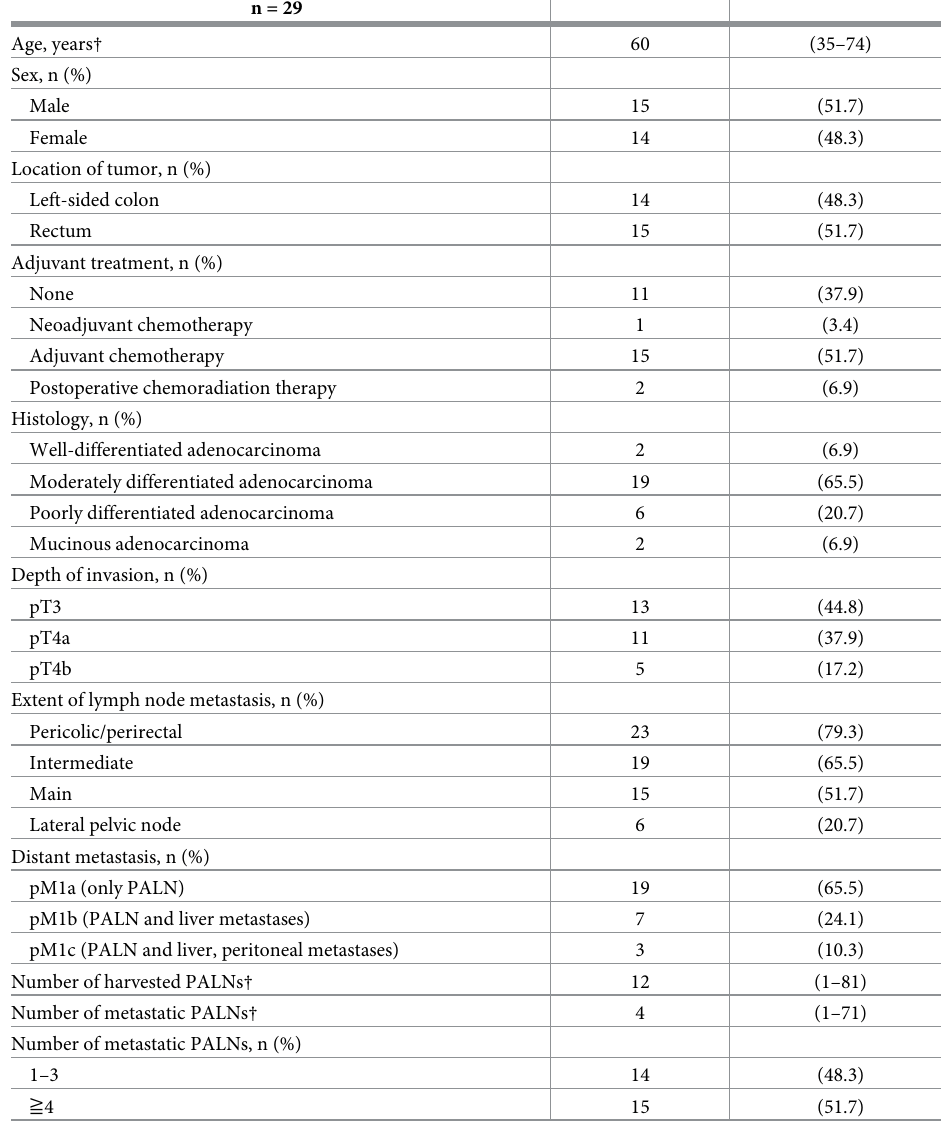
Table 1. Clinicopathological